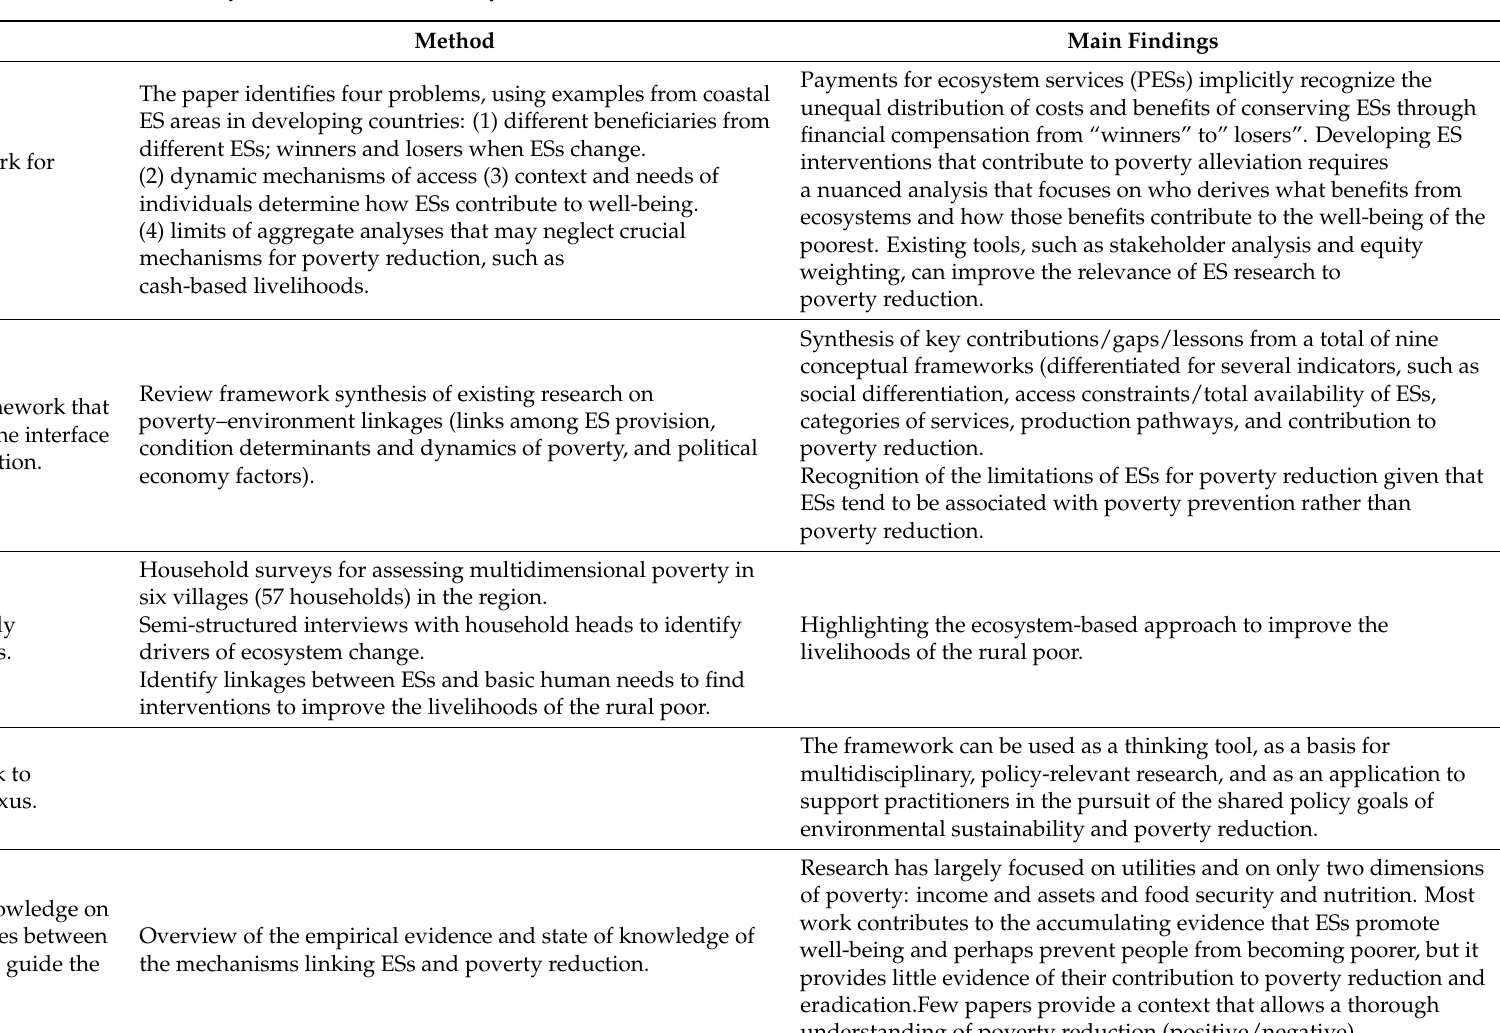
Table 1. Selected Studies on Ecosystem Services and Poverty